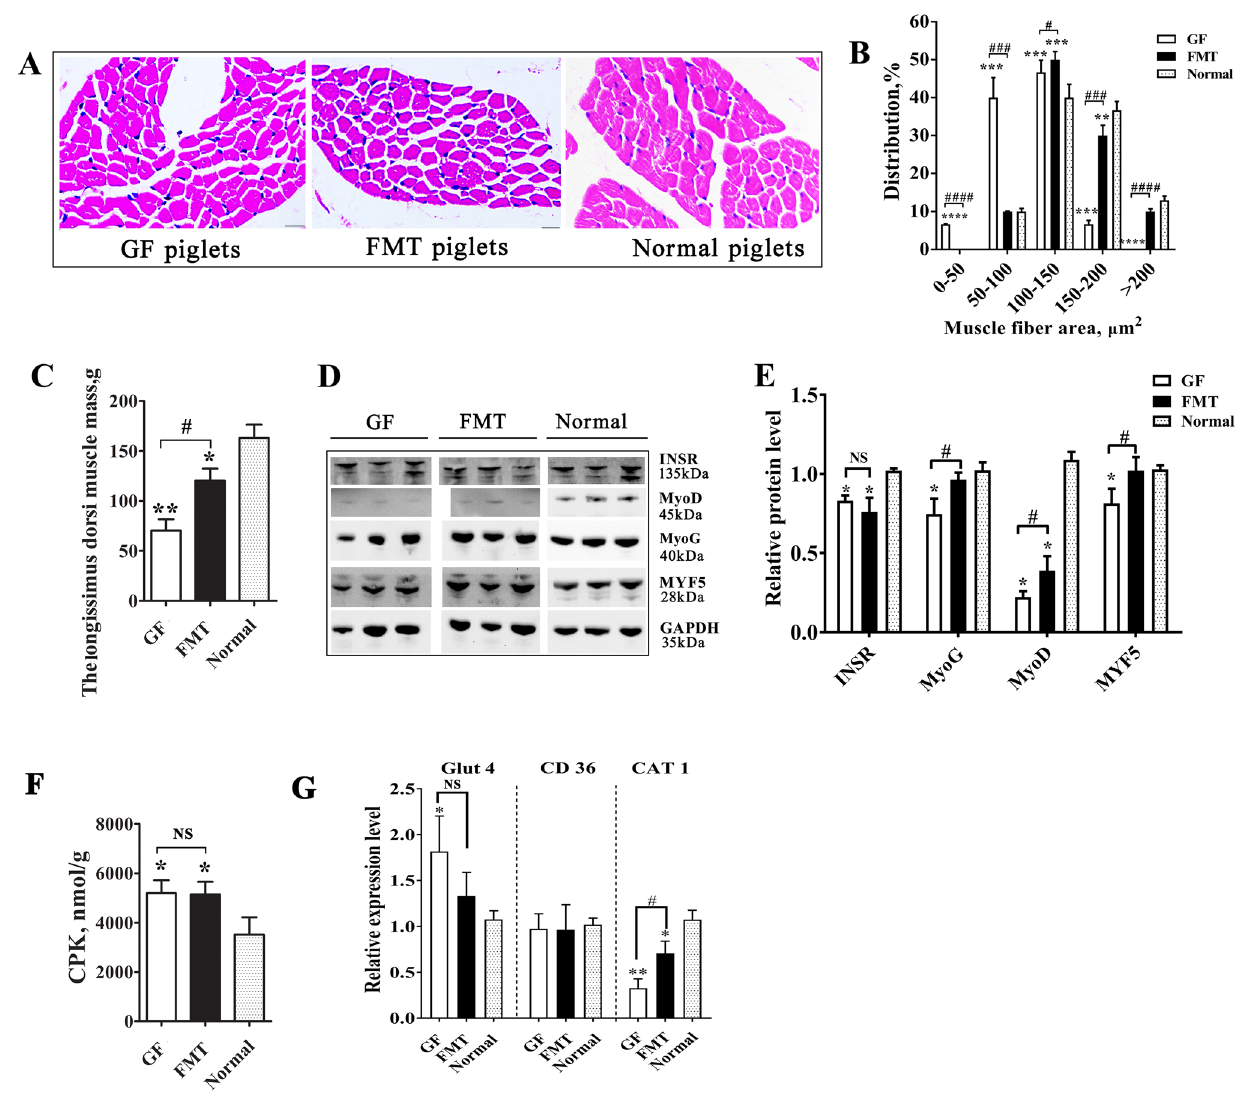
Figure 3. Comparison of muscle growth in different piglets. ( A ) Sections of the longissimus dorsi muscle with hematoxylin–eosin (HE) staining. ( B ) Sectional area of muscle fiber. ( C ) Weight of the left longissimus dorsi muscle mass. ( D ) Protein levels of key myogenic factors and insulin receptor (INSR) as detected by Western blotting. The full-length blots are presented in Supplementary Fig. 1. ( E ) Relative quantitative analysis of the protein levels. ( F ) Enzyme activity of creatine phosphokinase (CPK) in muscle tissue. ( G ) Expression levels of glucose transporter 4 (Glut4), fatty acid translocase (FAT/CD36) and cationic amino acid transporter 1 (CAT1). mRNA expression in the muscle tissue was determined by qPCR. N = 3, the data are presented as the means ± s.e.m. * P < 0.05, ** P < 0.01, *** P < 0.001, and **** P < 0.0001 compared to the normal piglets (control). # P < 0.05, ### P < 0.001, and #### P < 0.0001 between the GF piglets and the FMT piglets. NS not significant, GF piglets germ-free piglets, FMT piglets GF piglets with fecal microbiota muscles of GF piglets than in normal piglets (Fig. 3D,E). In particular, the protein level of MyoD in GF piglets was less than that in normal piglets (30%, P < 0.01). Although not completely comparable to the normal pig- lets, the FMT piglets also showed larger muscle mass and thicker muscle fibers ( P < 0.05) than the GF piglets. The protein levels of myogenic factors in the FMT piglets increased accordingly (especially MYF5 and MyoG). The development and metabolism of skeletal muscle in mammals are closely controlled by insulin signals 28 . Insulin and IGFs in circulation bind to receptor proteins in different organs, which then activate downstream pathways 29 . We found that the insulin receptor (INSR) in the longissimus dorsi muscle also showed a reduction in protein levels in GF piglets (Fig. 3D). Creatine phosphokinase (CPK) is an important enzyme involved in energy metabolism and is mainly found in skeletal muscle and the myocardium. CPK enzyme activity has been reported to be elevated in individuals with progressive muscular dystrophy, polymyositis or muscle damage 30 . Our data showed that the CPK level in GF piglet muscle was 1.47-fold that in normal piglets ( P < 0.05, Fig. 3F), which was indicative of abnormal